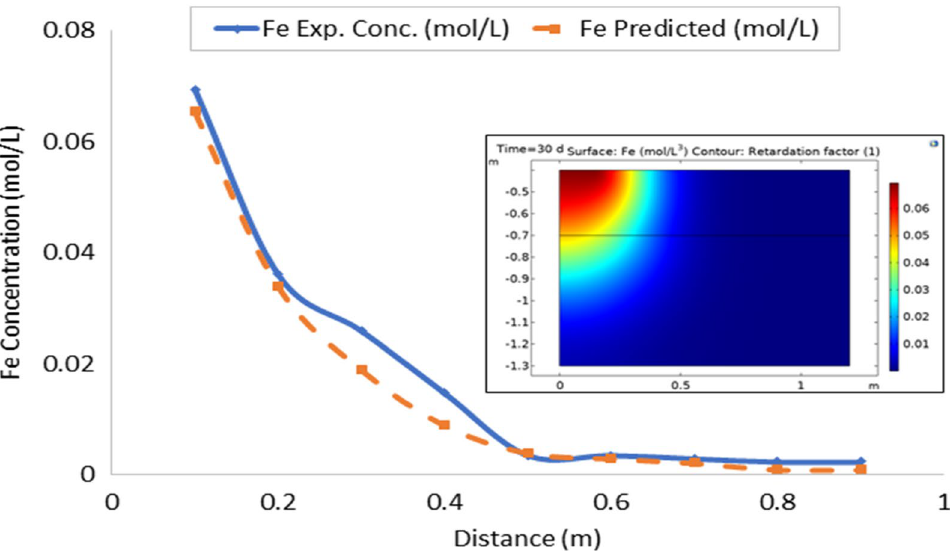
Figure 10. Fe transport in dumpsite soil of the study